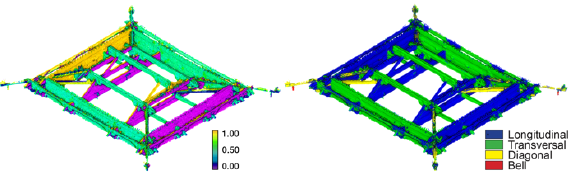
Figure 6. Results for level 3 classification on the truss of the great hall of NCS. Normals in x direction (left) and classification labels